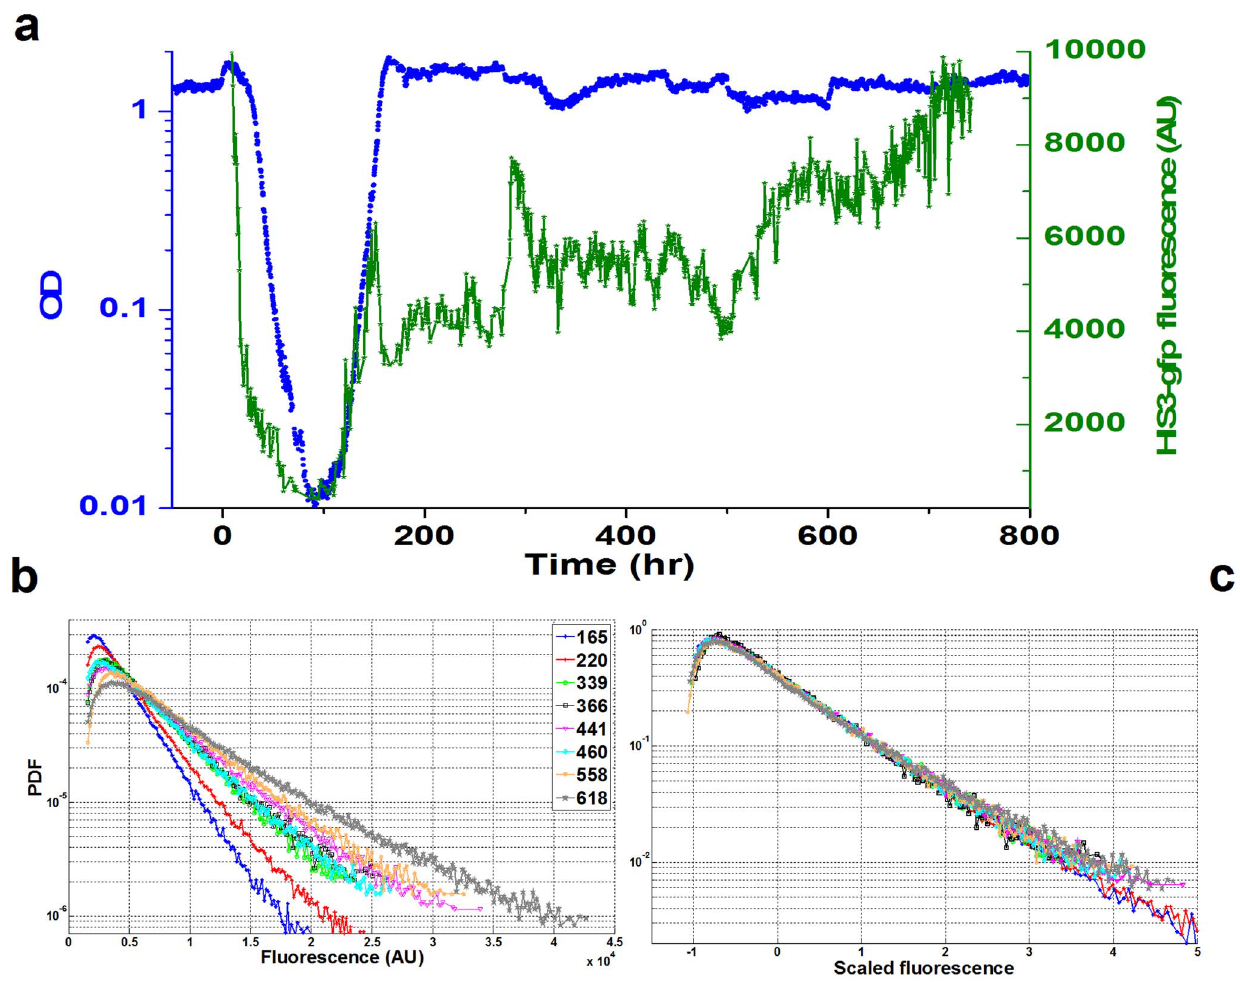
Figure 2. HIS3-GFP dynamics in a chemostat population. (a) The average HIS3 -GFP fluorescence of the chemostat population (green) as a function of time for the same experiment as in Fig. 1. The population-average fluorescence was extracted from statistics over single-cell measurements utilizing our home-made cytometer online with the chemostat. The protein content fluctuates by up to a factor of two, hundreds of hours into phase IV. The optical density is shown in blue for reference. (b) Distributions of the single-cell HIS3-GFP for several time-points during phase-IV. (c) All the distributions from (b) collapse to a single curve when subtracting the mean and dividing by standard deviation of each